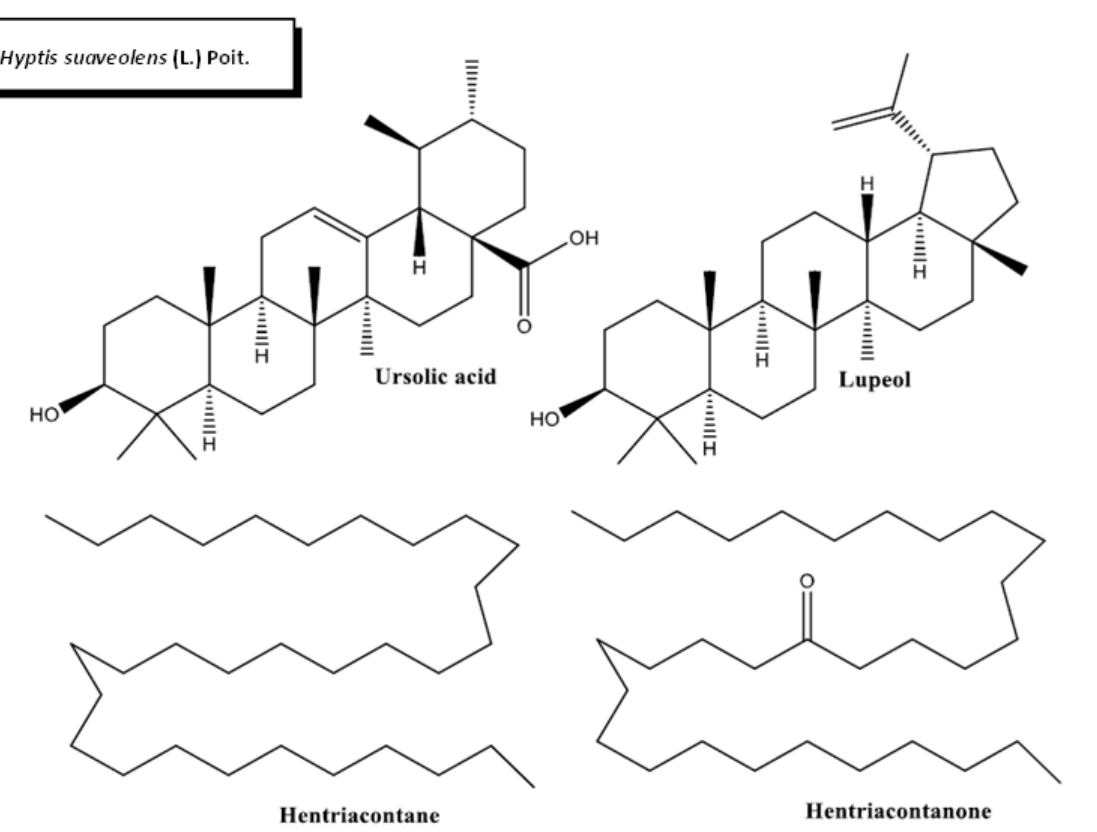
Figure 4. Chemical structures of bioactive phytocompounds with reported antidiabetic properties identified in Hyptis suaveolens (L.) Poit.